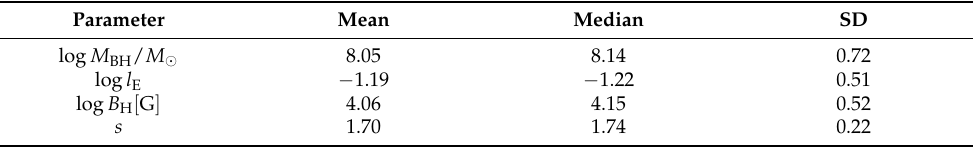
Table 3. Basic statistical properties of the parameters. “Mean” indicates the arithmetic mean, “Median” the median value, “SD” the standard